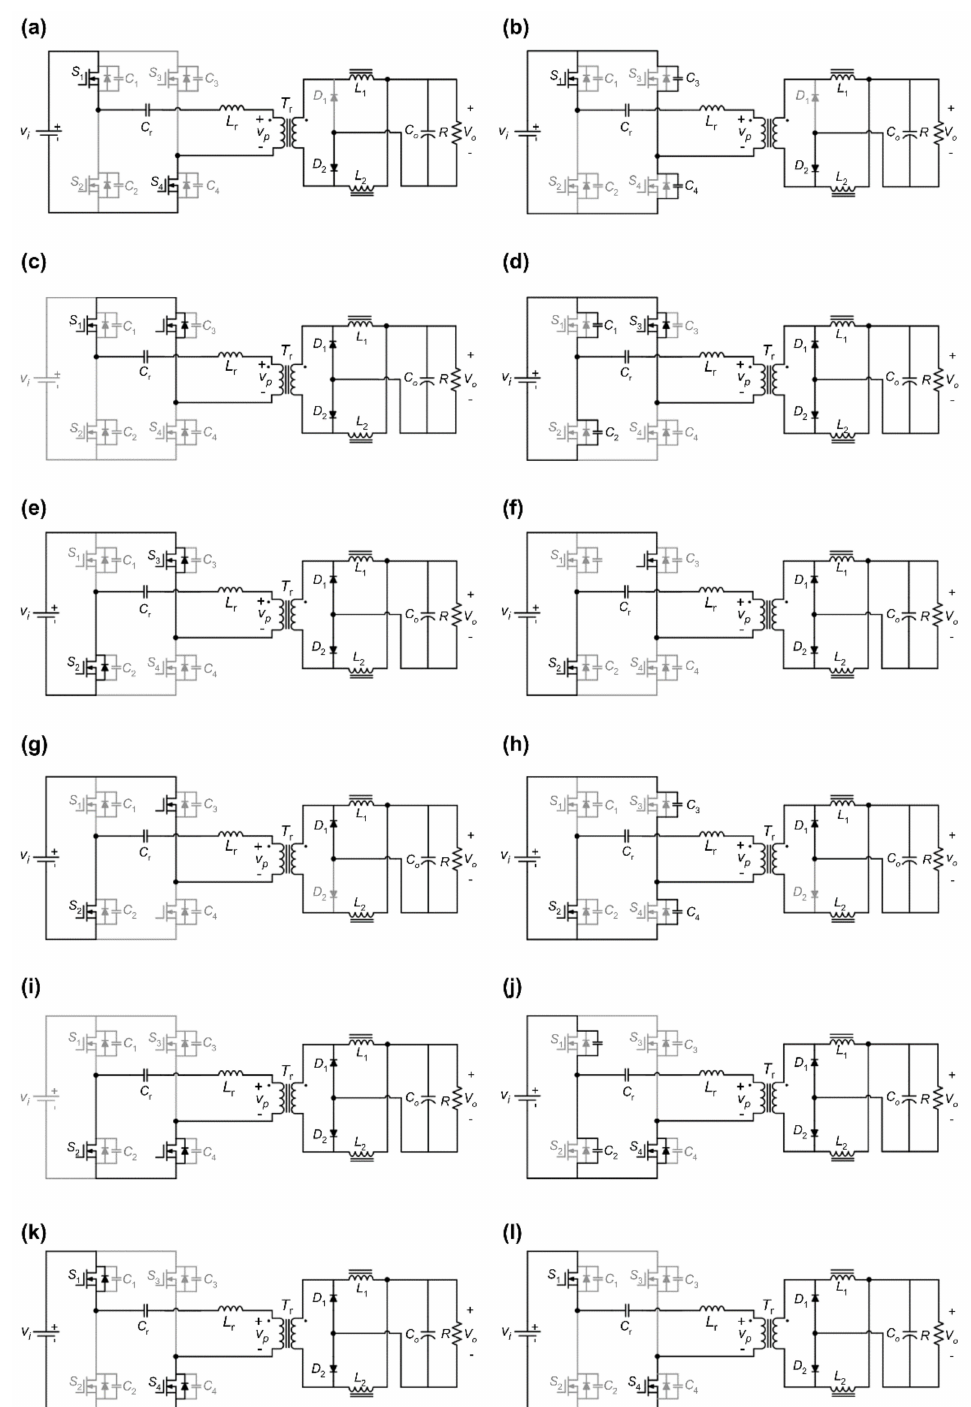
Figure 8. Equivalent circuits of the operating modes. ( a ) Mode 1 ( t 0 ≤ t < t 1 ) ( b ) Mode 2 ( t 1 ≤ t < t 2 ) ( c ) Mode 3 ( t 2 ≤ t < t 3 ) ( d ) Mode 4 ( t 3 ≤ t < t 4 ) ( e ) Mode 5 ( t 4 ≤ t < t 5 ) ( f ) Mode 6 ( t 5 ≤ t < t 6 ) ( g ) Mode 7 ( t 6 ≤ t < t 7 ) ( h ) Mode 8 ( t 7 ≤ t < t 8 ) ( i ) Mode 9 ( t 8 ≤ t < t 9 ) ( j ) Mode 10 ( t 9 ≤ t < t 10 ) ( k ) Mode 11 ( t 10 ≤ t < t 11 ) ( l ) Mode 12 ( t 11 ≤ t < t 12 ). Mode 1 [ t 0 ≤ t < t 1 ]: Figure 8a shows the equivalent circuit of this mode. In this mode, switches S 1 and S 4 are turned on, and transformer primary side voltage v p equals input voltage v i . The input energy is transferred to the secondary side through switches S 1 , S 4 , and the transformer. The energy from the primary side is transferred to the output